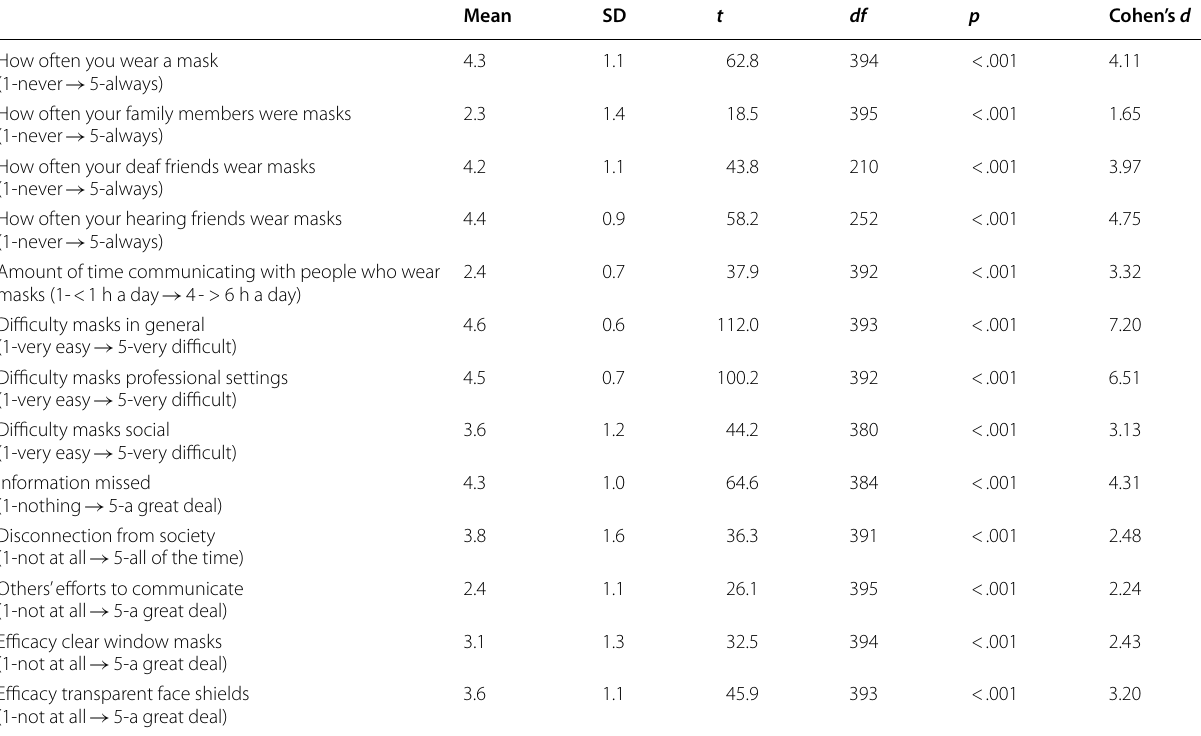
Table 3 Average values and one sample t ‑tests for frequency of mask use and dependent